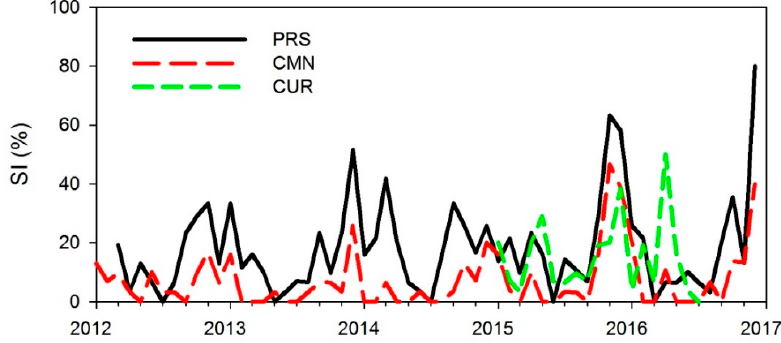
Figure 4. Time series of monthly in situ SI detections at the three measurement sites (2012–2016). Table 3. Agreement in percentage between in situ SI detection and STEFLUX outputs as a function of event duration. For each station, the number of in situ SI events are provided, together with the percentage of detection by STEFLUX (within